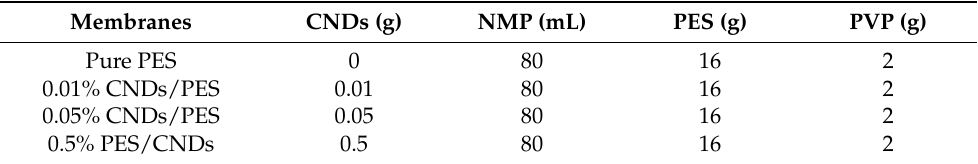
Table 1. Material amounts for composite membrane